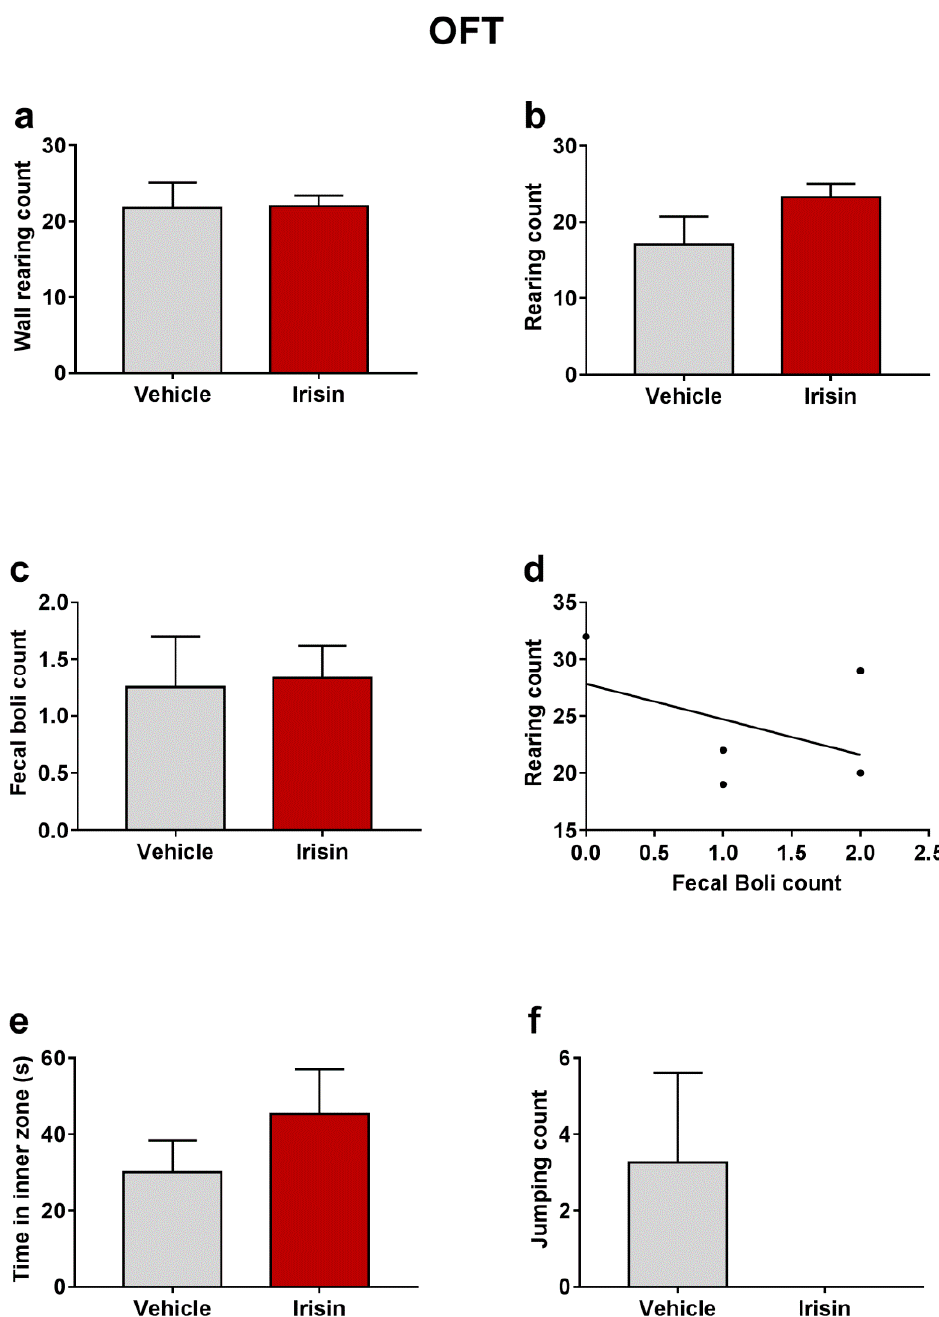
Figure 2. Effect of irisin long-term systemic administration on the wall rearing count ( a ), rearing count ( b ), and fecal boli count ( c ) in the OFT. Correlation between rearing and fecal boli count ( d ). Time spent in inner zone ( e ) and jumping count ( f ) in the OFT. Histograms represent mean values ± SEM. Unpaired two-tailed Student’s t -test was used for statistical analysis of wall rearing and rearing count and time spent in inner zone. Unpaired Mann–Whitney test was used for fecal boli and jumping count. The Spearman’s rank correlation test was used to correlate the fecal boli and rearing counts.